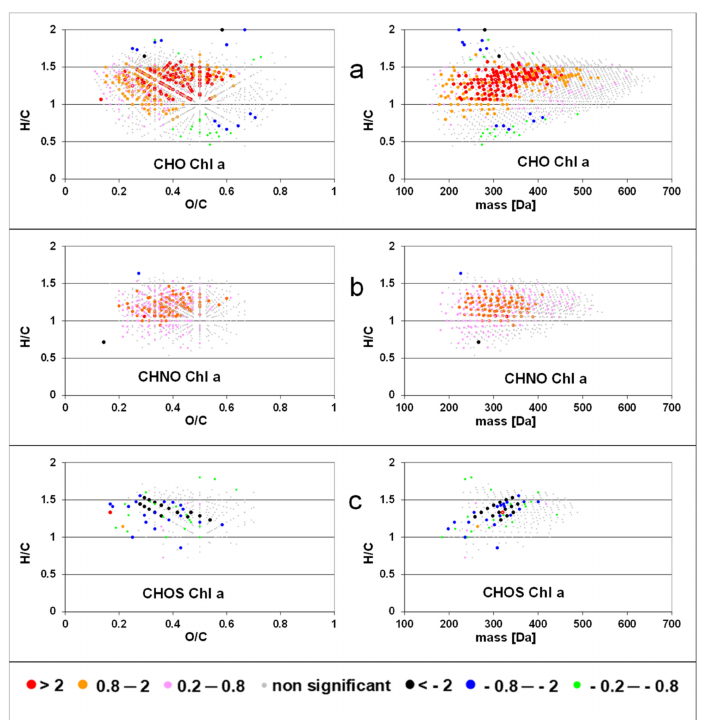
Figure 2. Slopes of regressions between intensities of solid phase extractable dissolved organic matter (SPE-DOM) molecular formulas and standardized chlorophyll a concentration for CHO ( a ); CHNO ( b ); and CHOS components ( c ). See also the data base in the Supplementary Materials.